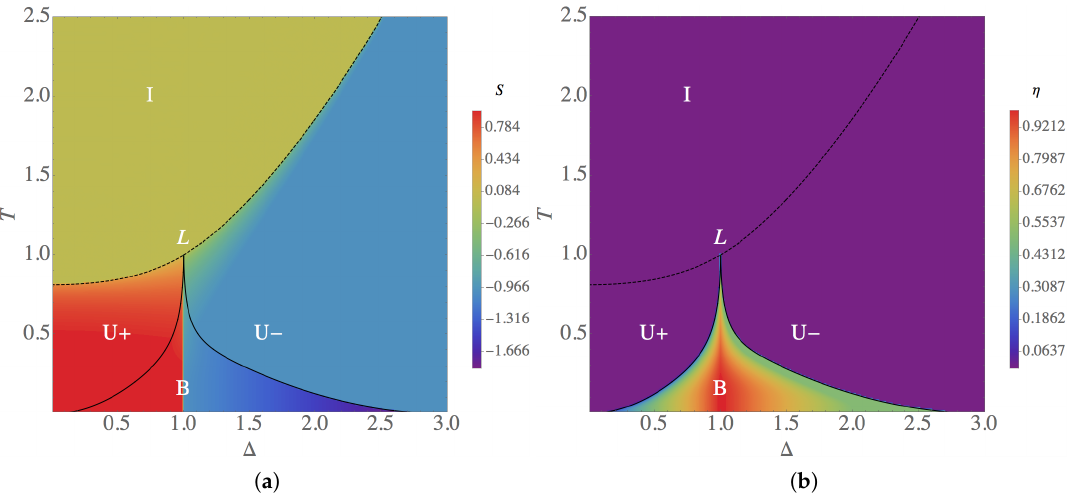
Figure 1. Phase diagram at zero field, in the T × ∆ plane. The color code shows the behavior of ( a ) the uniaxial order parameter S , which is zero in the high-temperature isotropic phase (I), and ( b ) the biaxial order parameter η , which is nonzero only in the low-temperature biaxial (B) phase. Notice that at low and intermediate temperatures the value of S associated with the smallest equilibrium value of | η | changes sign along the line ∆ = 1 on which the Landau point ( ∆ L , T L ) = ( 1,1 ) is located. Solid (dashed) lines indicate continuous (first-order) transitions. The calamitic (U+) and discotic (U-) uniaxial phases are also